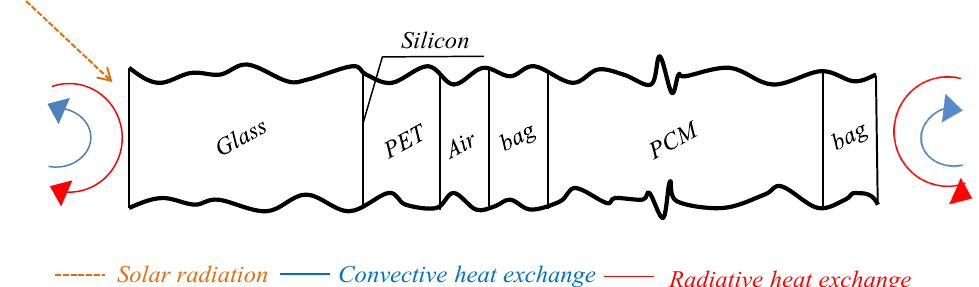
Figure 1. PV-PCM cross-section (thicknesses not presented at real scale, for clarity of